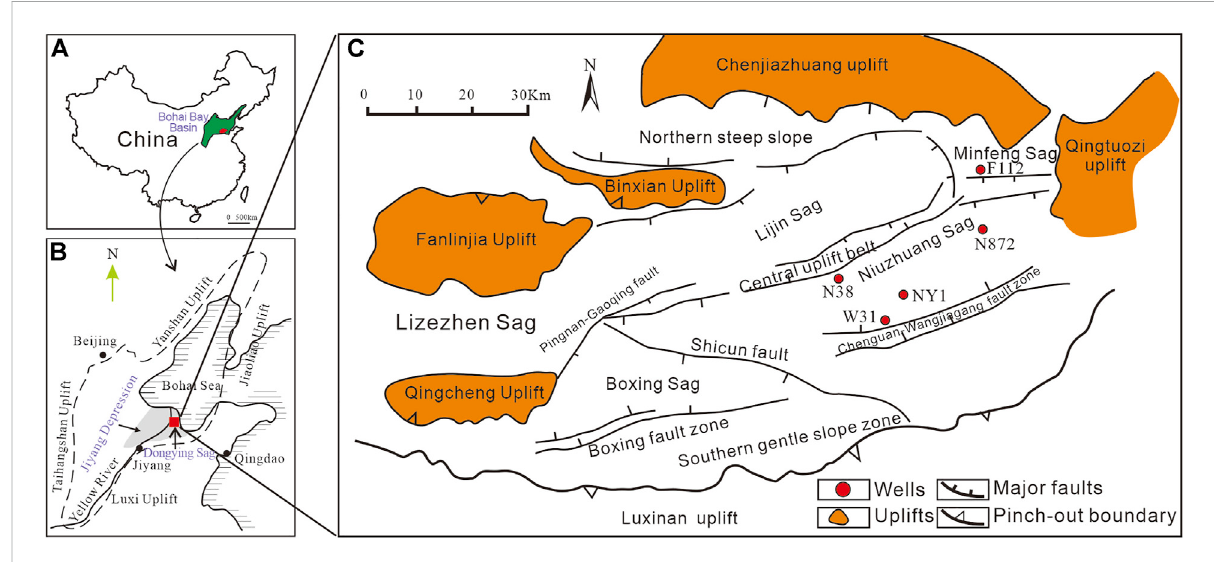
FIGURE 1 Locationmap. (A,B) LocationoftheDongyingSag. (C) StructuralfeaturesoftheDongyingSagandthesamplingwelllocations